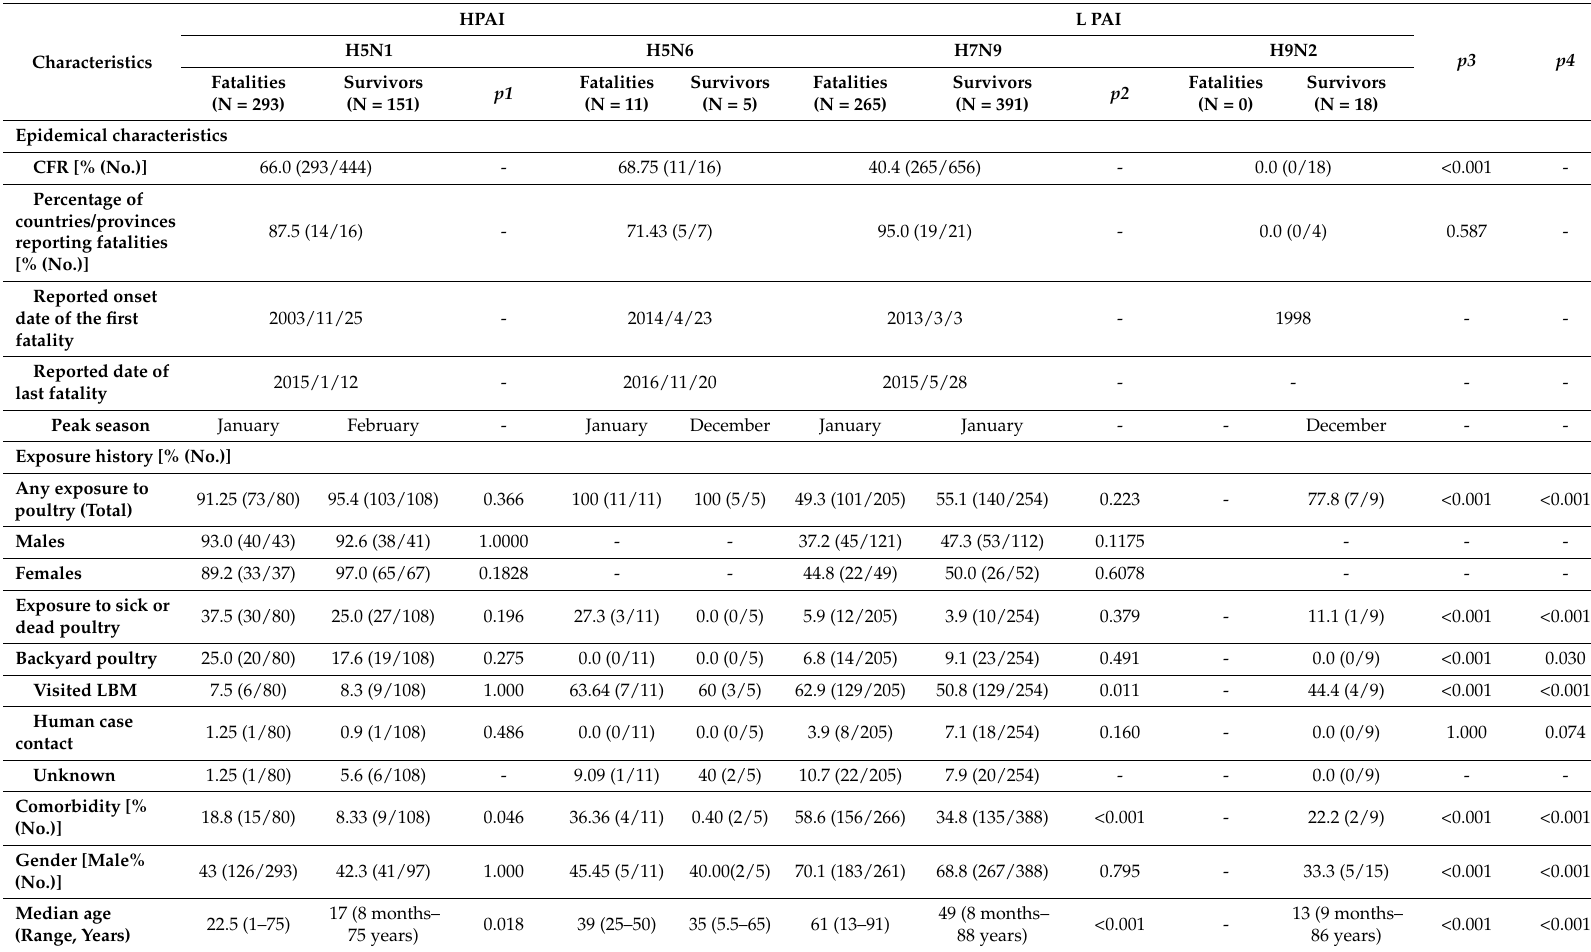
Table 1. Epidemical and clinical comparison of highly pathogenic avian influenza and low pathogenicity avian influenza fatalities and survivors.